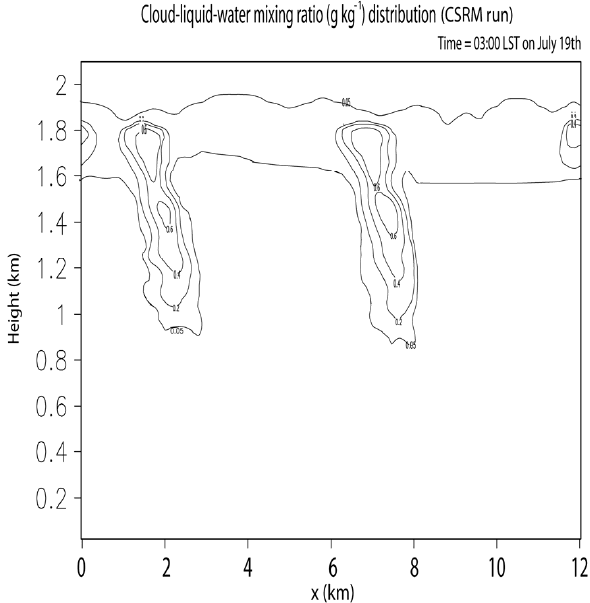
Fig. 9. Contours of cloud-liquid-water mixing ratio (gkg − 1 ) at the time of the occurrence of maximum depth of the averaged cloud- liquid-water mixing ratio (03:00LST 19 July) along the x (east- west) direction in the middle of the y (north-south) direction in the CSRM run. Contours are at 0.05, 0.2, 0.4, and 0.6gkg − 1 .